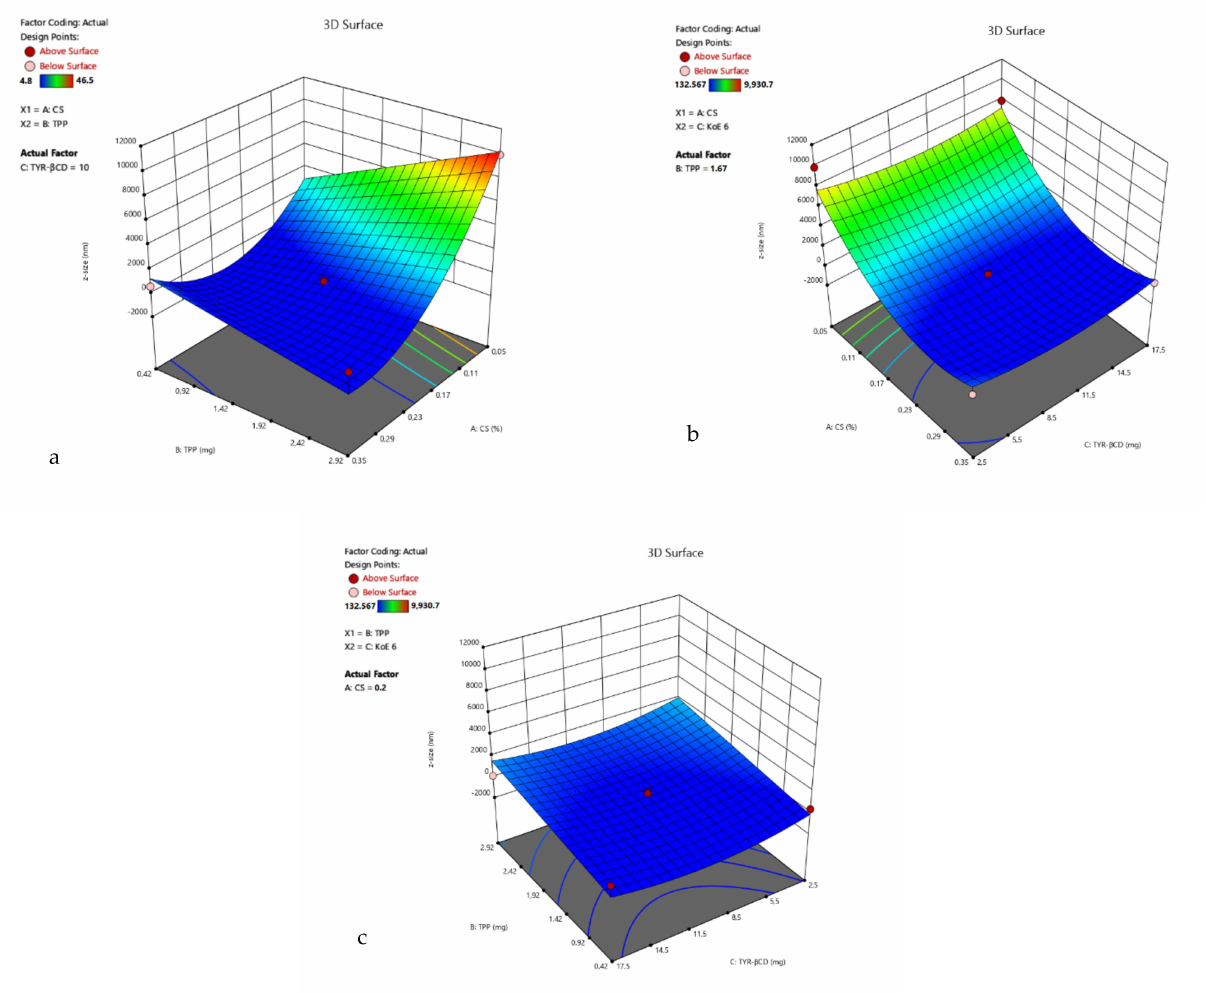
Figure 4. 3D surface plot of response R 1 of TYR- β CD/CS system ( a ) CS Vs TPP (TYR- β CD: 10 mg) ( b ) CS Vs TYR- β CD (TPP: 1.67 mg) ( c ) TPP Vs TYR- β CD (CS: